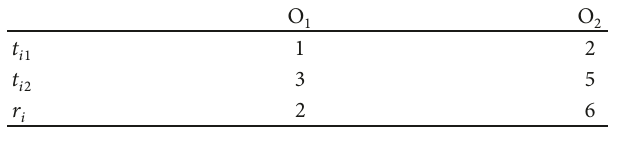
Table 1: Data for Example 1.